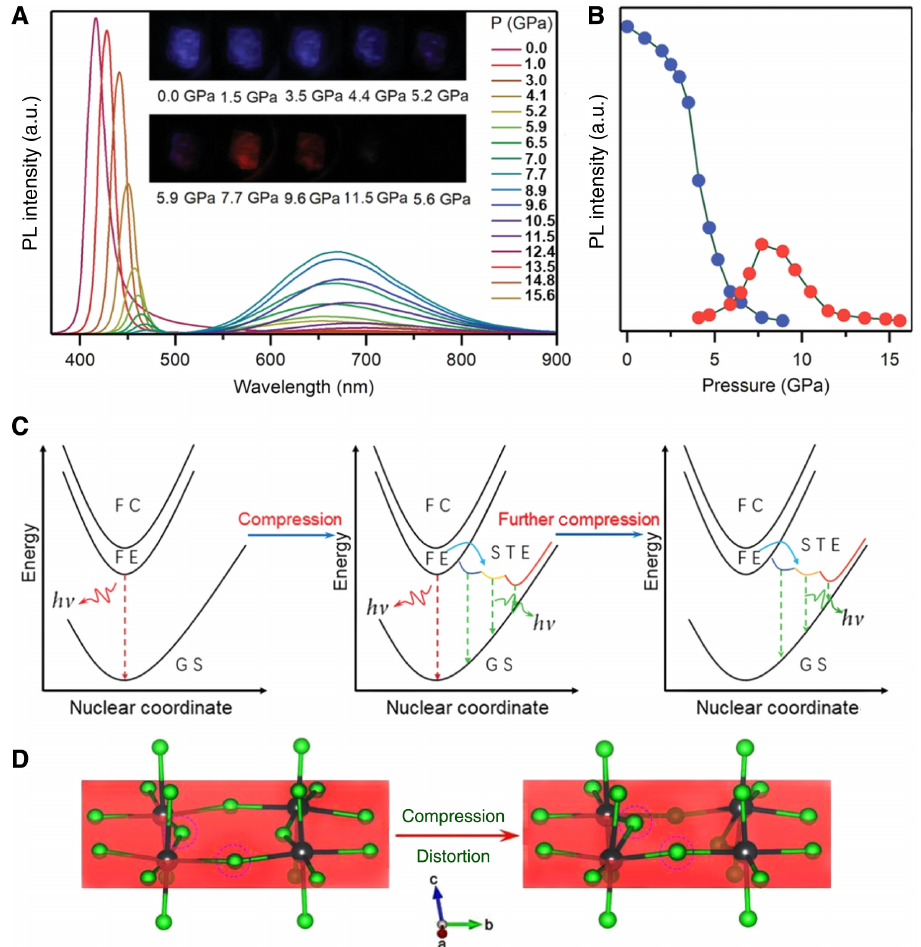
PbBr perovskite under varied pressures. Figure 7: Broadband emission of (PEA) 2 4 (A) PL spectra of (PEA) PbBr perovskite as a function of pressure at room temperature. The illustrations are PL micrographs upon 2 4 compression. (B) Pressure-induced PL intensity evolution of (PEA) PbBr . (C) Schematic illustrations of emission evolutions upon 2 4 compression. Ground state (GS), free-carrier state (FC), free-exciton state (FE), and various self-trapped exciton state (STE). (D) Schematic diagram of Pb-Br inorganic layer distortion in (PEA) PbBr upon compression. Gray ball: Pb, green ball: Br. Reprinted from Ref. [101] with 2 4 permission from the